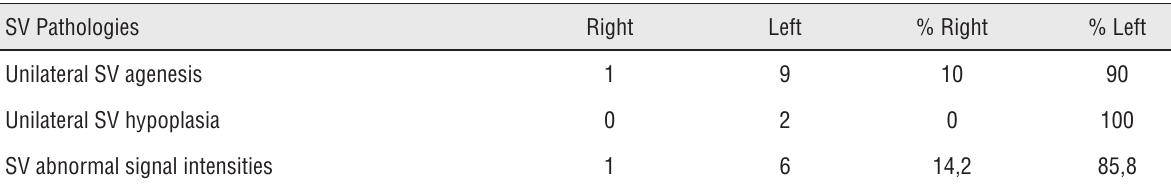
Table 3 - Left side preponderance in sv pathologies. SV Pathologies Right